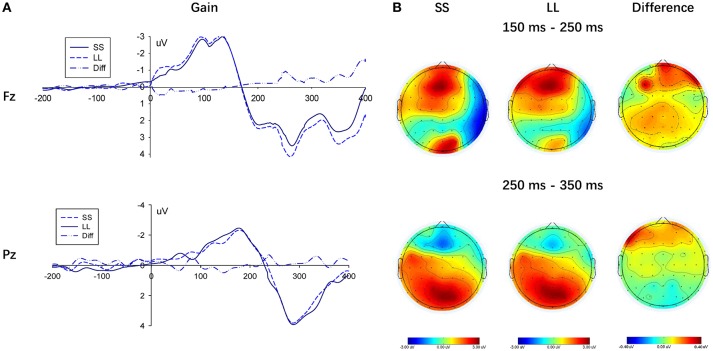
Results of selecting SS option and LL option in the gain condition. (A) Representative example: ERP waveform in Fz and Pz; (B) topographic maps for P200 (150 ms-250 ms), N2 (250 ms-350 ms) and P300 (250 ms-350 ms).